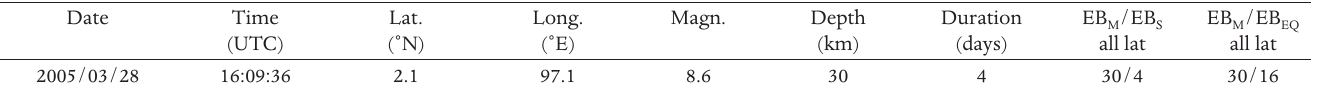
Table 2. Characteristics of the catastrophic earthquake of March 28, 2005, in North Sumatra. The electron bursts in the two last columns are conside- red for DEMETER orbits at all